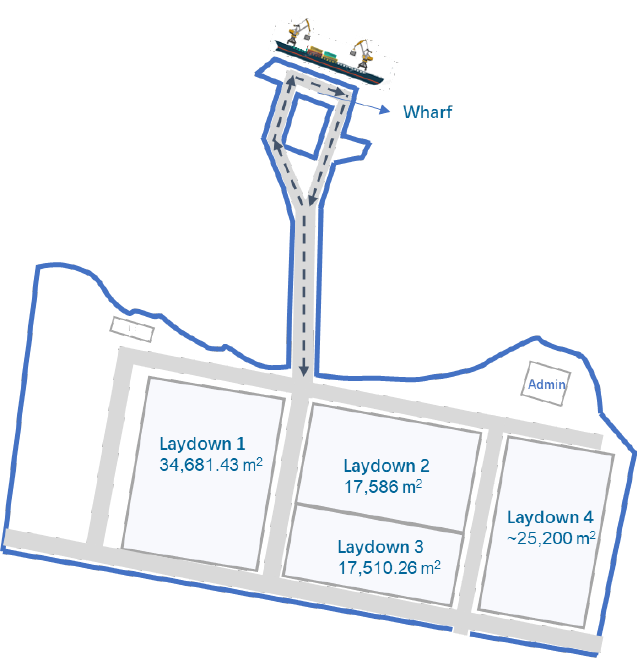
Figure 2. Layout of the studied B Port. Different handling methods are used for container cargo and break bulk